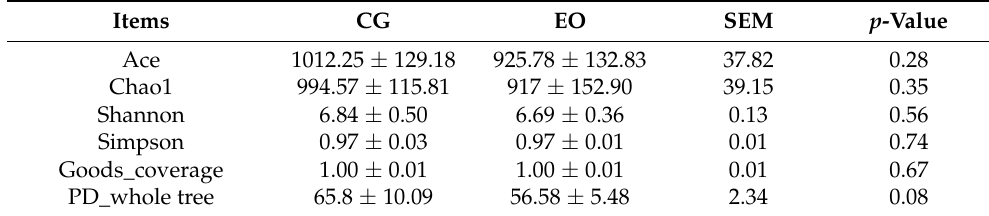
Abbreviations: CG, control group; EO, essential